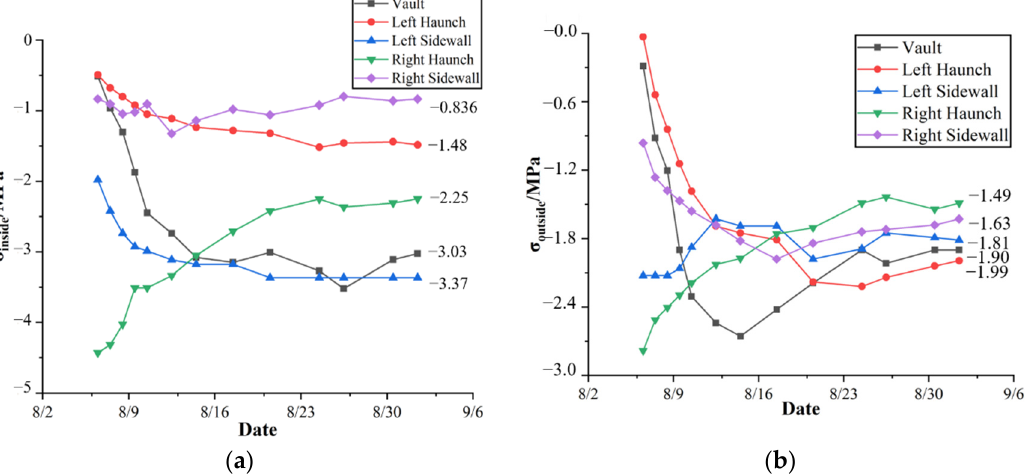
Figure 12. Measured concrete stress of the secondary lining. It went stable after about a month. ( a ) inside secondary lining; ( b ) outside secondary